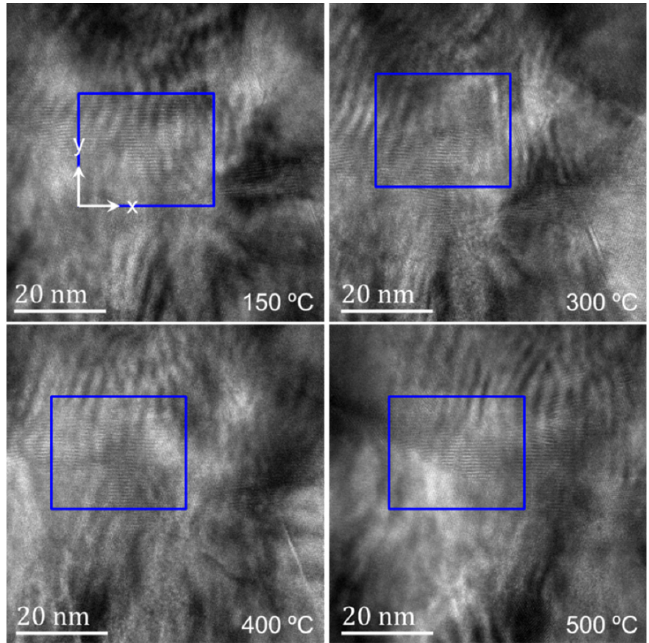
Figure 13. HRTEM images of TGO at different temperatures.